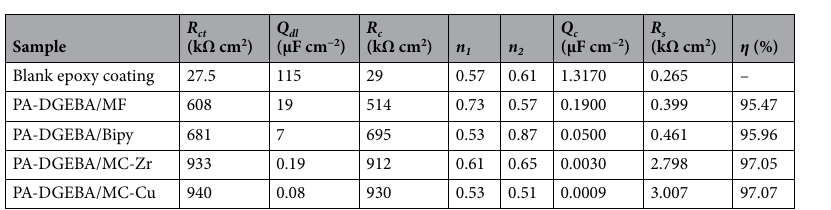
Table 6. EIS Parameters for different modified epoxy coated films against blank conventional epoxy (70– 75 µm thickness) in oil-wells formation water solution.